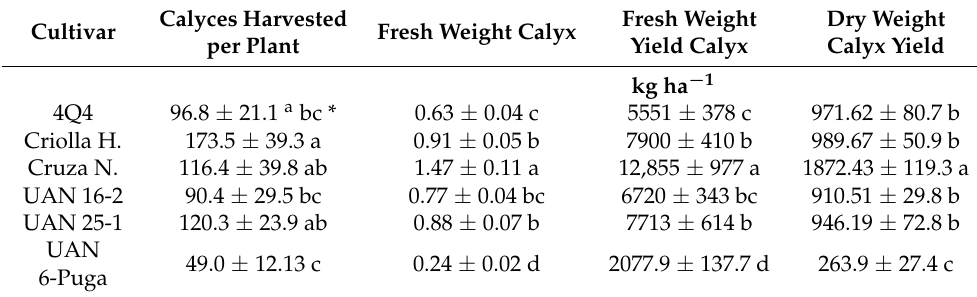
Fresh Weight Dry Weight Yield Calyx Calyx